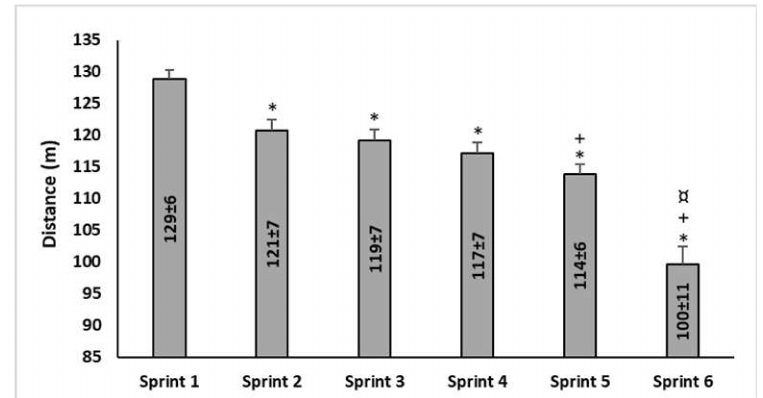
Figure 1. Distances covered in each 30-s sprints repetition (in meter) of the 5mSRT. *: Significantly shorter than the 1st sprint; + : Significantly shorter than the 2nd and the 3rd sprints; ¤: Significantly shorter than the 5th and the 6th